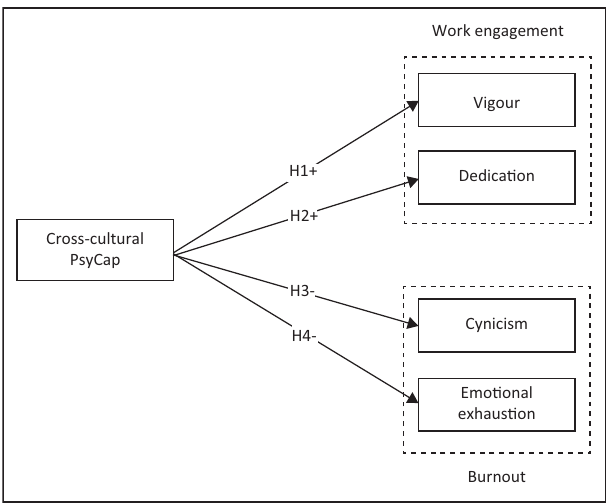
FIG URE 1: The conceptual model and